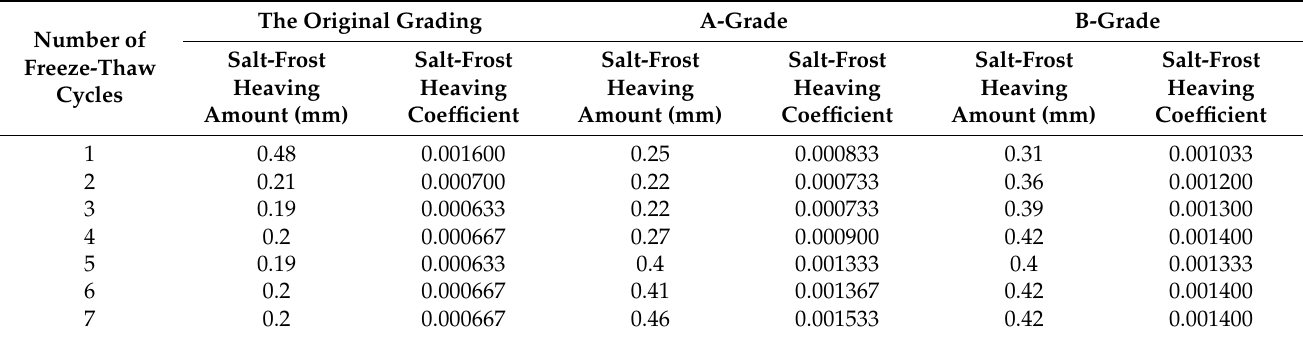
Table 4. Statistical table of dissolution and salt-frost heave of